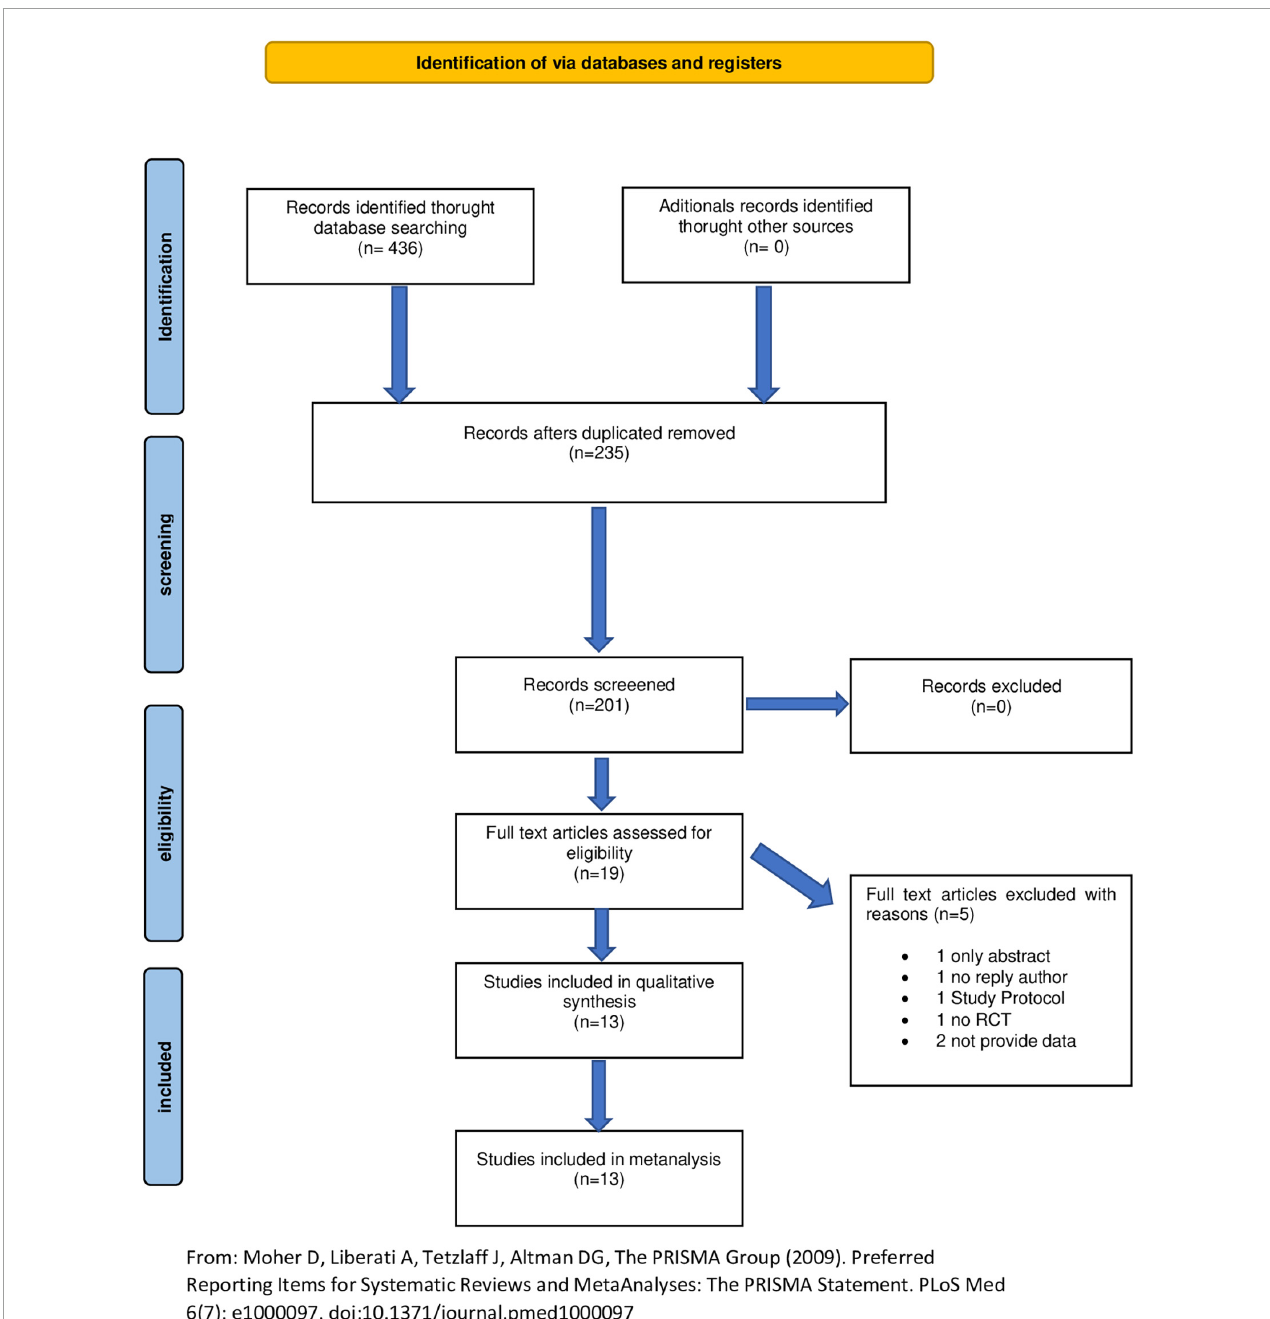
FIGURE1 Identification of via databases and registers. Adapted from Moher et al.